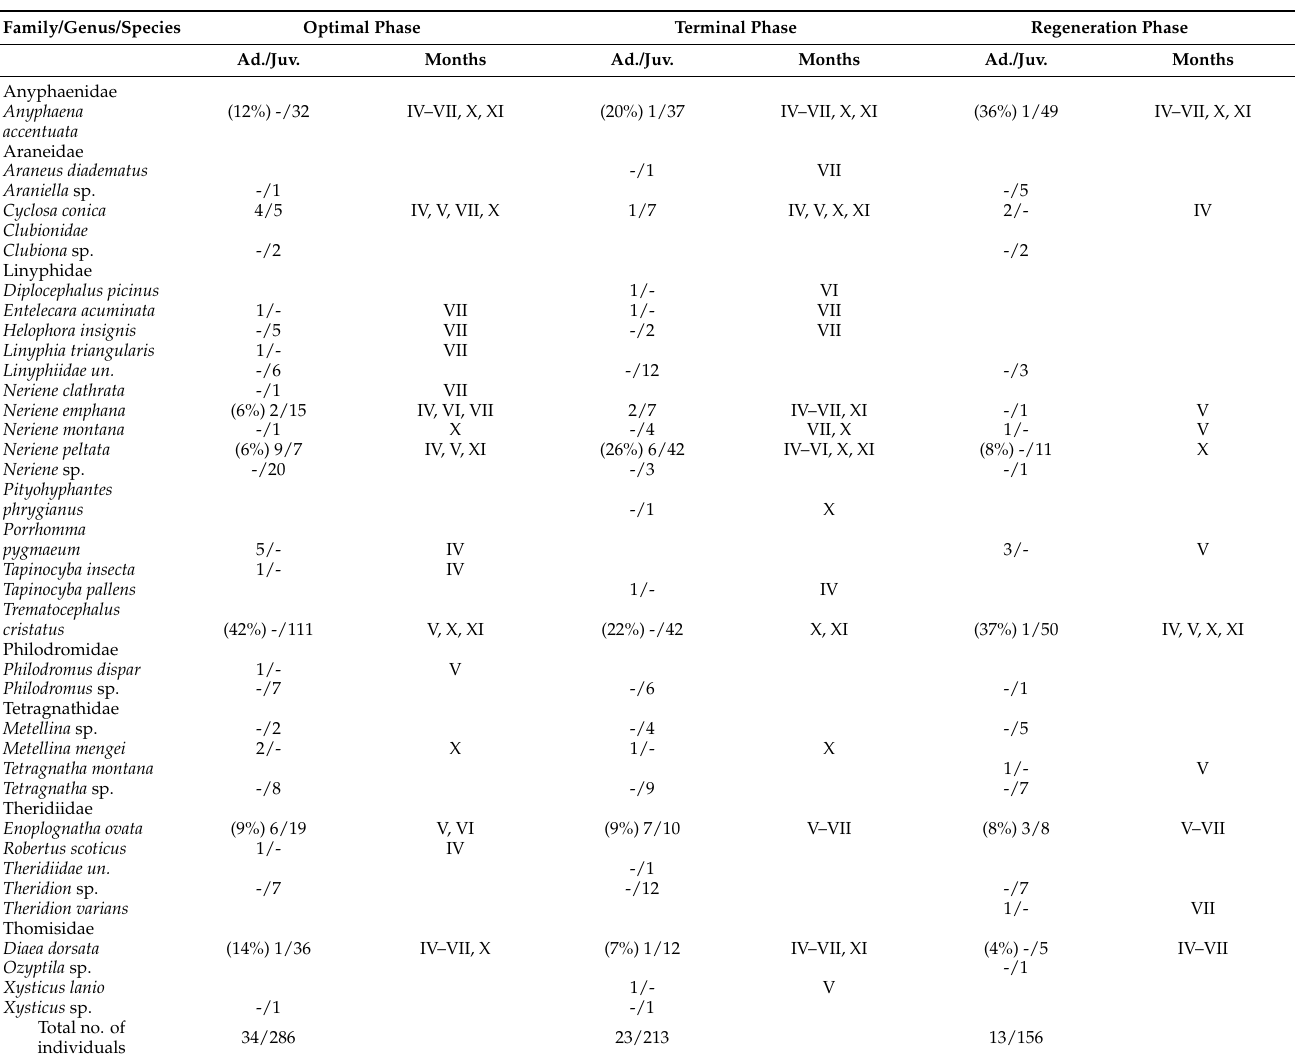
Table 1. Spiders collected on tree branches in three developmental phases of oak–lime–hornbeam stands in the Białowie˙za National Park (spider families, genus and species in alphabetical order). The percentages presented in parentheses, next to the number of individuals, show the proportion of each species. All individuals identified to the species level were included in the percentage composition, but values are only shown for species that reached at least 5%. Abbreviations: Ad./Juv.— number of adult/juvenile spider individuals, un.—individuals identified only to the family level. Roman letters indicate the months in which a given species was recorded.